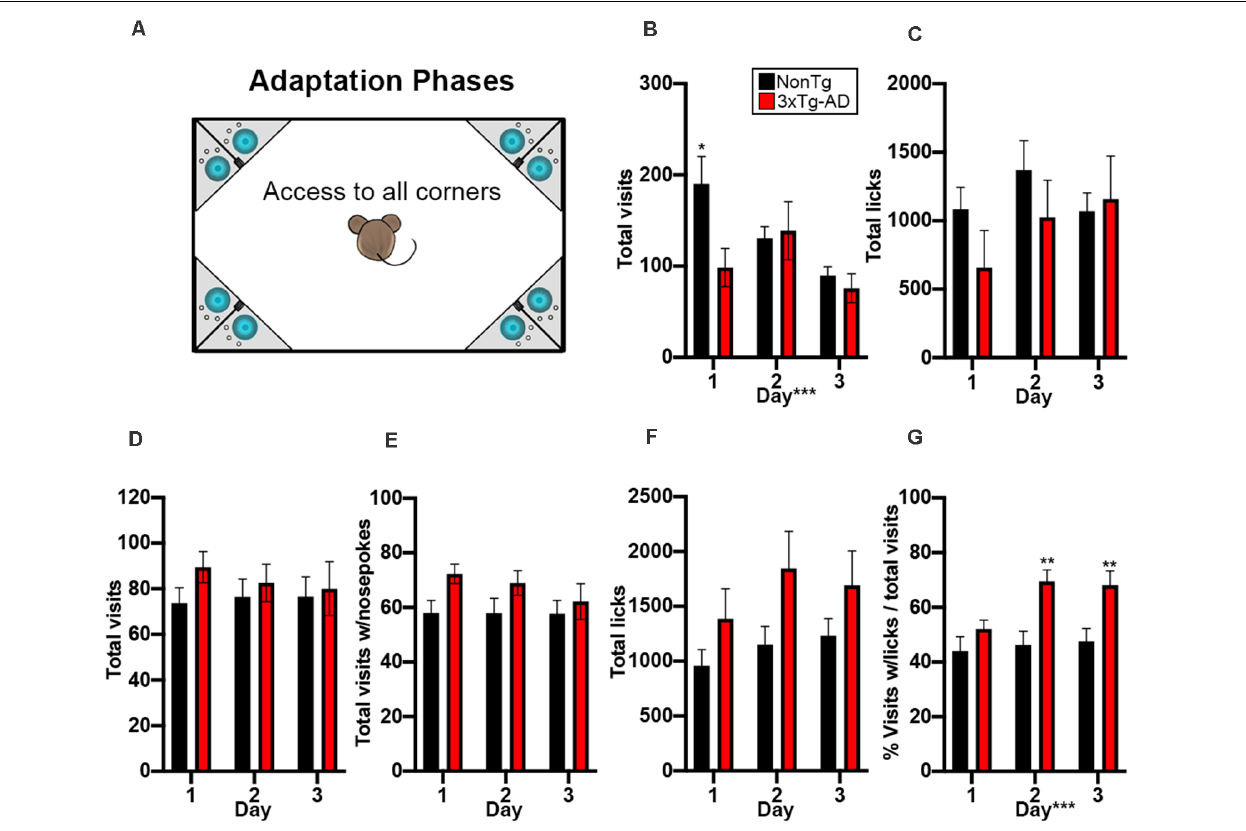
FIGURE 2 | NonTg mice explore more and drink less than 3xTg-AD mice in the adaptation phases. (A) During the 3-day adaptation phase, animals freely entered any of the four corners and could access water: cage not drawn to scale. (B) We found that NonTg mice made more corner visits on day 1 compared to 3xTg-AD mice ( p < 0.05). We also found that the number of visits decreased from day 1–3 ( p < 0.001). (C) No differences detected in total licks. In the 3-day nosepoke adaptation phase, animals must learn to nosepoke to access water. (D–F) No significant differences were detected in total visits, total visits with a nosepoke,